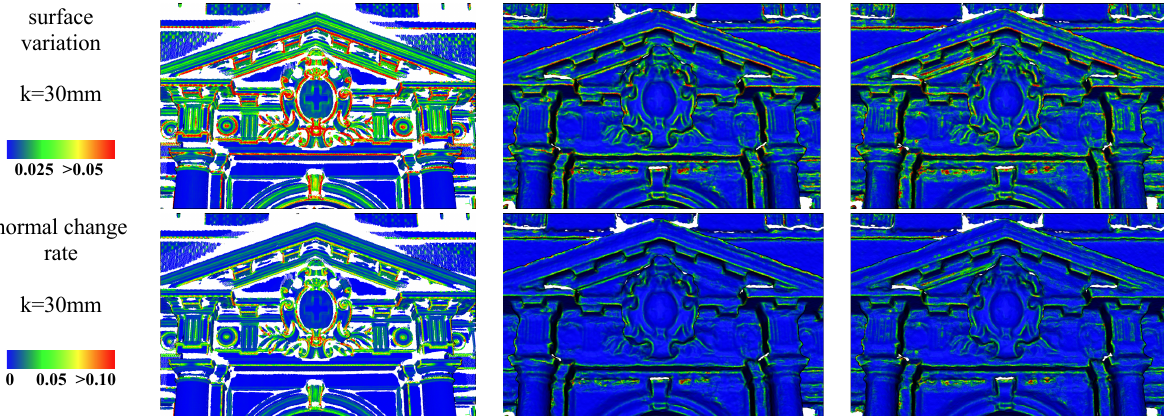
Figure 7. ETH3D-Façade: surface variation and normal change rate for GT (left), standard mesh (centre), mesh with edges